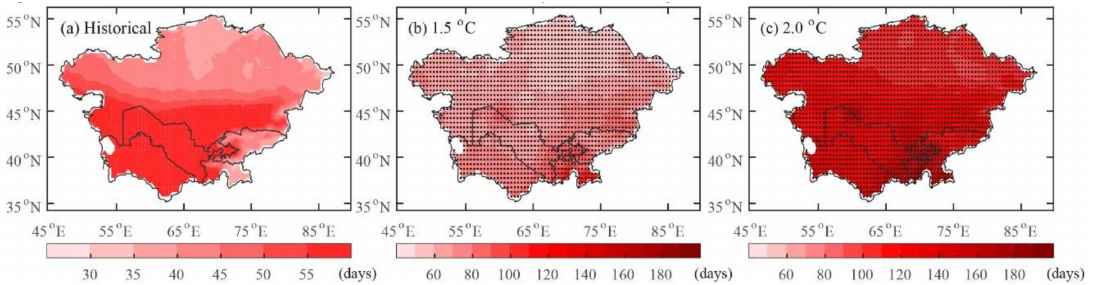
Figure 4. The spatial distribution of the warm days (TX90P) in the reference period (1986–2005) ( a ) and the di ff erence under 1.5 ◦ C ( b ) and 2 ◦ C ( c ) global warming relative to the reference period. Dark gray dots indicate that the increasing trends are significant at the 1% level in these